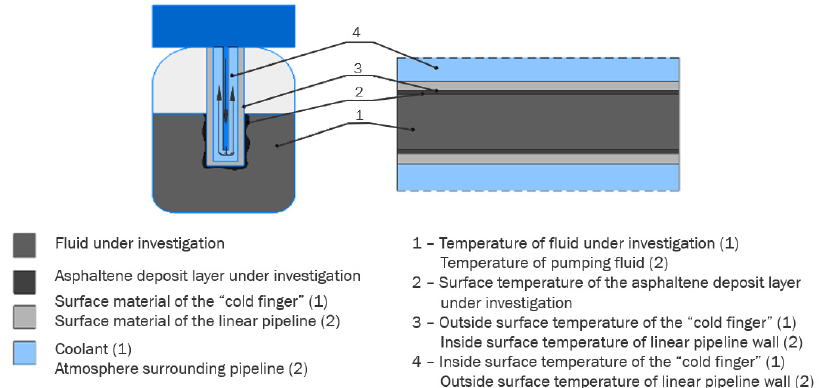
Figure 2. The principle of the reversed pipeline, implemented in the laboratory installation «Cold Finger».